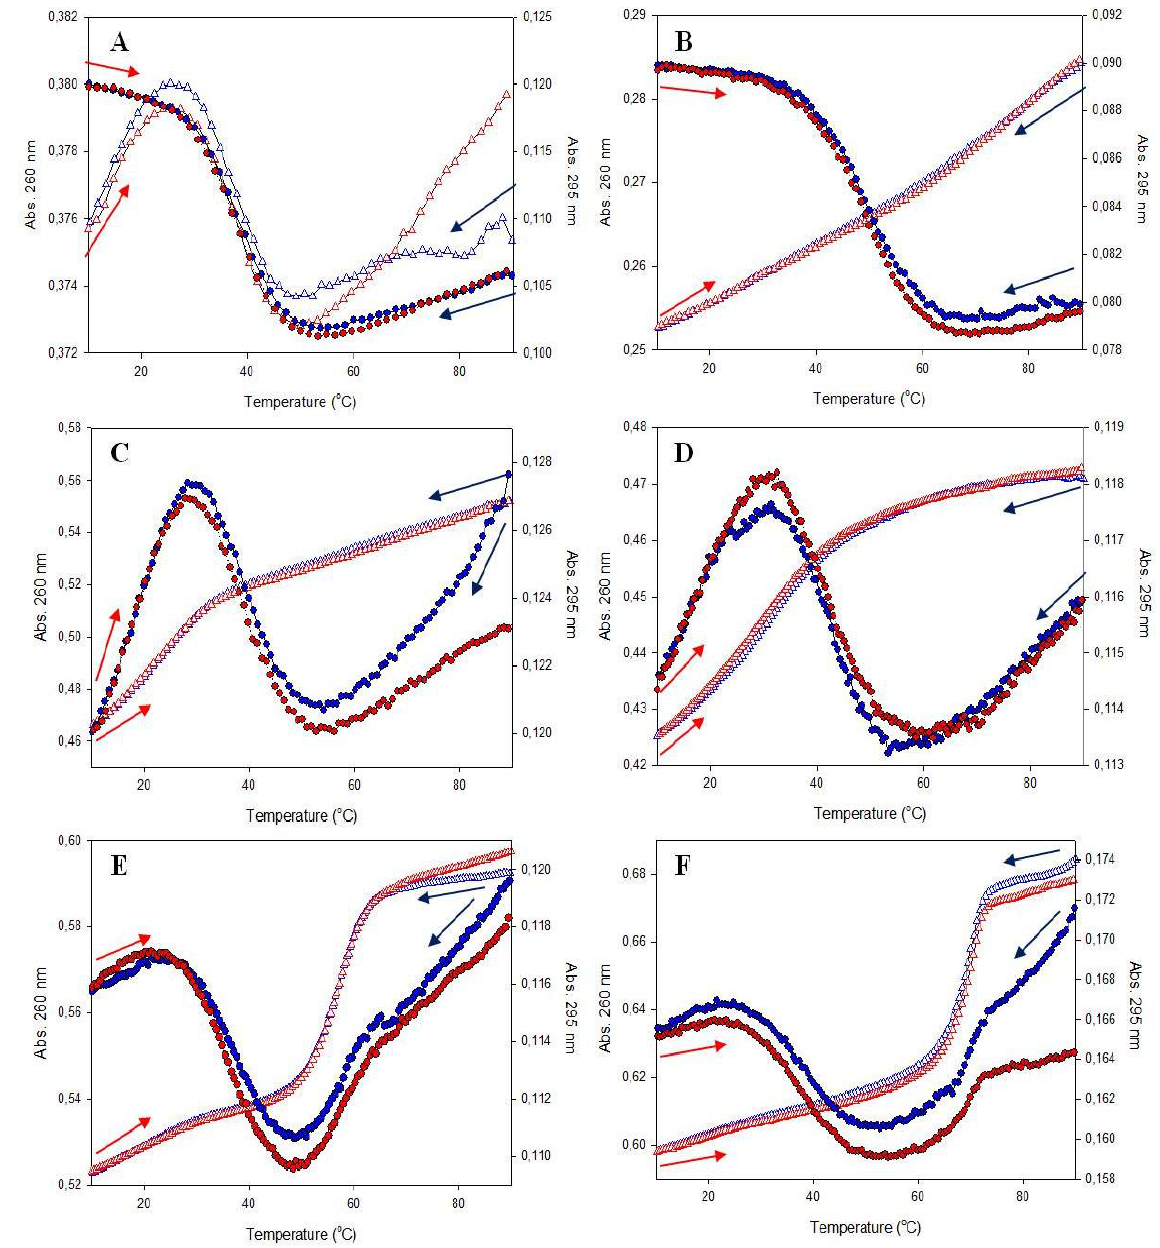
Figure 3. Denaturation profiles obtained for the ( A ) F19T, ( B ) ChF19T, ( C ) 16 F19T, ( D ) Ch16F19T, ( E ) 16F19T/Ch16’, and ( F ) Ch16F19T/Ch16’ systems at two different wavelengths: 295 nm (full circles) and 260 nm (open triangles). Left vertical axis: absorbance values at 260 nm; right vertical axis: absorbance values at 295 nm. Experimental conditions: 1 μM strand concentration (A–D), 2 uM total strand concentration (E,F), 50 mM cacodylate buffer (pH = 7.5), 0.1 M KCl. The discrepancy at high temperatures between the heating and cooling curves is the result of evaporation: the experiment started with a cooling cycle ( i.e ., starting at a high temperature and slowly cooling) (blue profiles) followed by a heating cycle (red profiles). Note that the scales for the 260 nm and 295 nm readings are notably